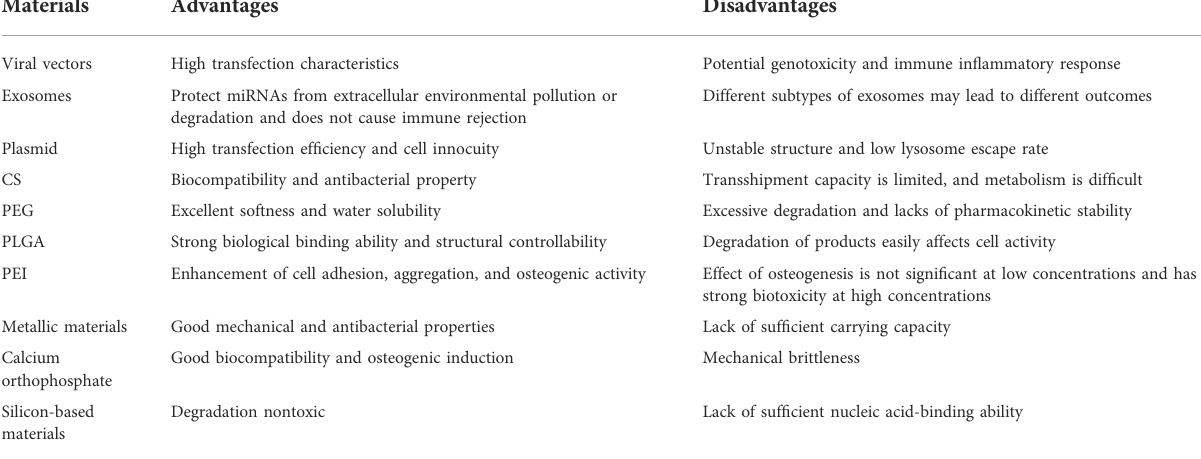
TABLE 2 Summary of advantages and disadvantages of various biological